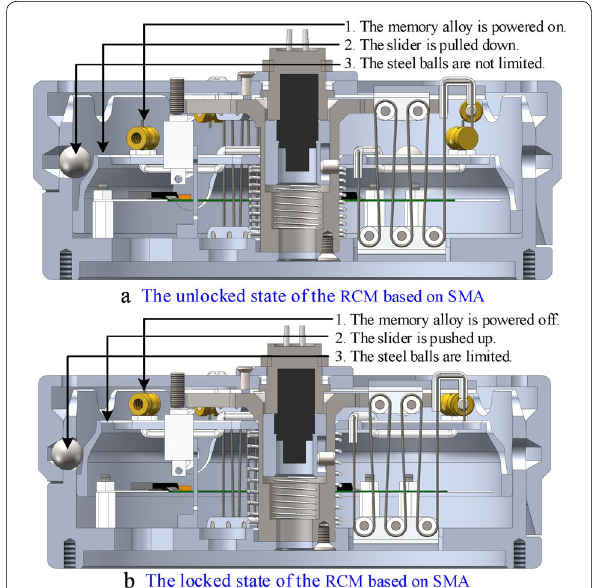
Figure 4 State of the RCM based on SMA